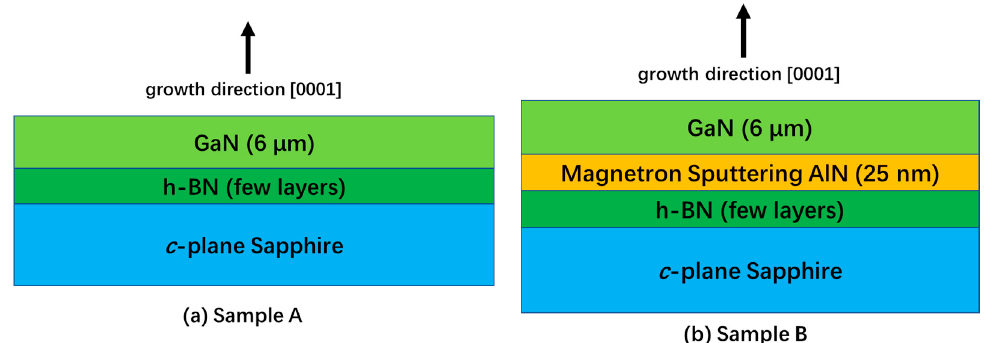
Figure 1. ( a ) GaN material epitaxially grown on h-BN/sapphire substrate of sample A and ( b ) GaN material epitaxially grow on h-BN / sapphire substrate of sample B after magnetron sputtering 25 material epitaxially grow on h-BN/sapphire substrate of sample B after magnetron sputtering 25 nm thick AlN.